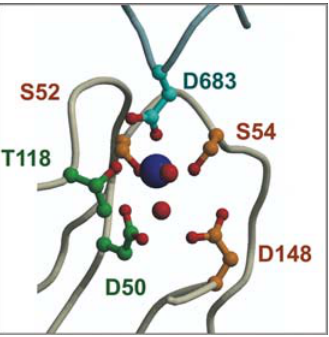
Figure 1. ANTXR2 MIDAS metal ion bound by PA D683. Close-up view of the PA-ANTXR2 generated with Molscript (PDB # ITZN) [7]. The PA backbone is colored light blue with the D683 residue shown in cyan. The chelate Mg 2 + ion is colored purple, the ANTXR2 Thr118 and Asp50 residues (mutated in this report) are shown in green with the other MIDAS residues represented in orange. Water molecules and oxygen atoms are represented by large and small red balls, respectively.